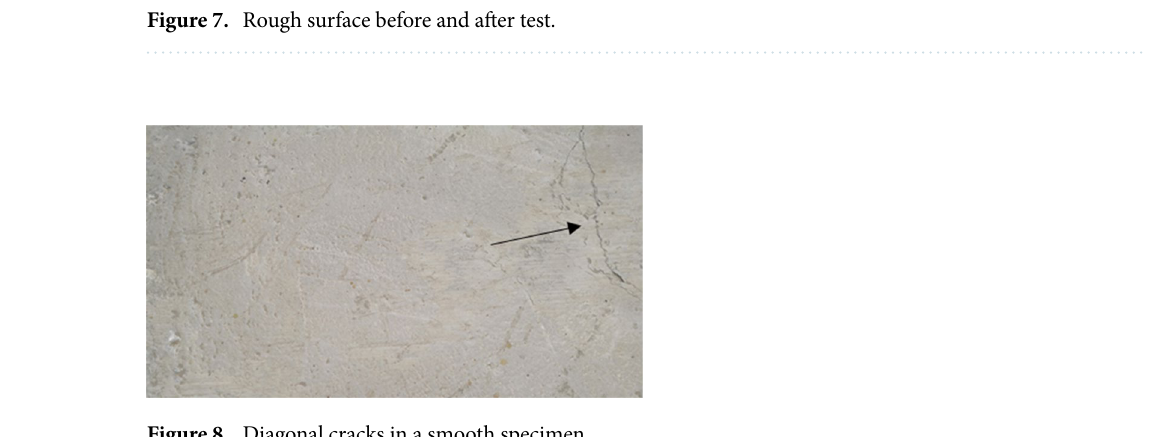
Figure 8. Diagonal cracks in a smooth